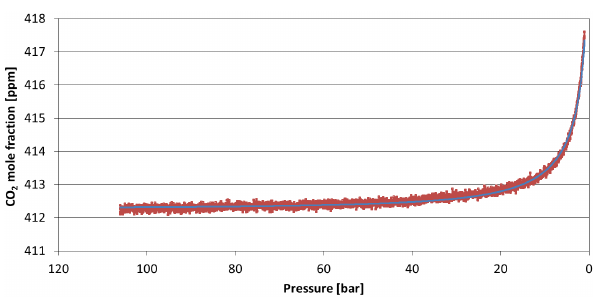
Figure 3. Emptying experiment within 14h: H 2 O even shows a 5- times stronger desorption effect documented by the linear correla- tion with the CO 2 mole